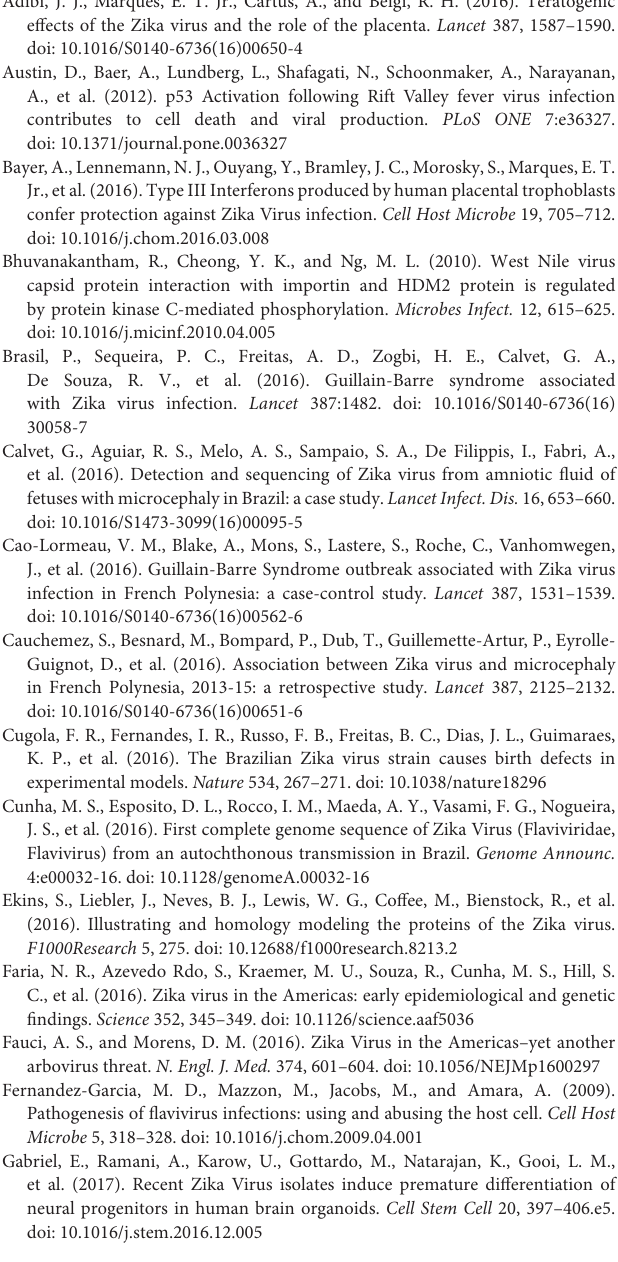
Figure S7 | Tetramer of ZCP (residues 25–104); ZPC mimic peptide (residues 74–104) is a purple helix; non-specific ZCP peptide (residues 30–53) is a green helix (A) . The docking complex of MDM2 and the ZCP peptide (residues 81–104; green helix). No interaction with MDM2 at residues 83, 99, 100, and 103 in the ZCP peptide (B) . Monomer of ZCP (residues 25–104); ZCP mimic peptide (residues 74–104; purple helix) and non-specific ZCP peptide (residues 30–53; green helix) (C) . Docking complex of MDM2 and the non-specific ZCP peptide (residues 30–53; green helix); there was no region of interaction between them (D) .